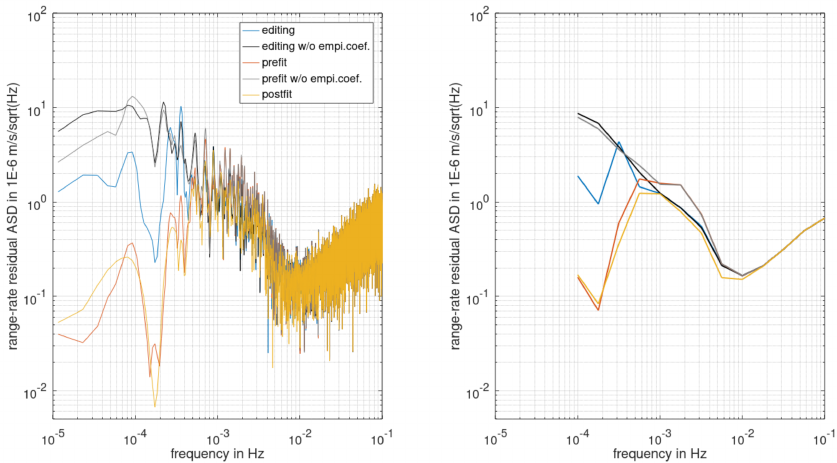
Figure 1. GRACE MWI range rate ASDs for 1 January 2007 for editing (blue), pre-fit (red) and post-fit (yellow) residuals with setting up empirical parameters, as well as editing and pre-fit residuals with- out setting up empirical parameters (black and gray). ( Left ) ASD using a 1-day Hann window [34]. ( Right ) smoothed mean ASD for 10 {− 4.00, − 3.75, − 3.50, ... − 1.00 }